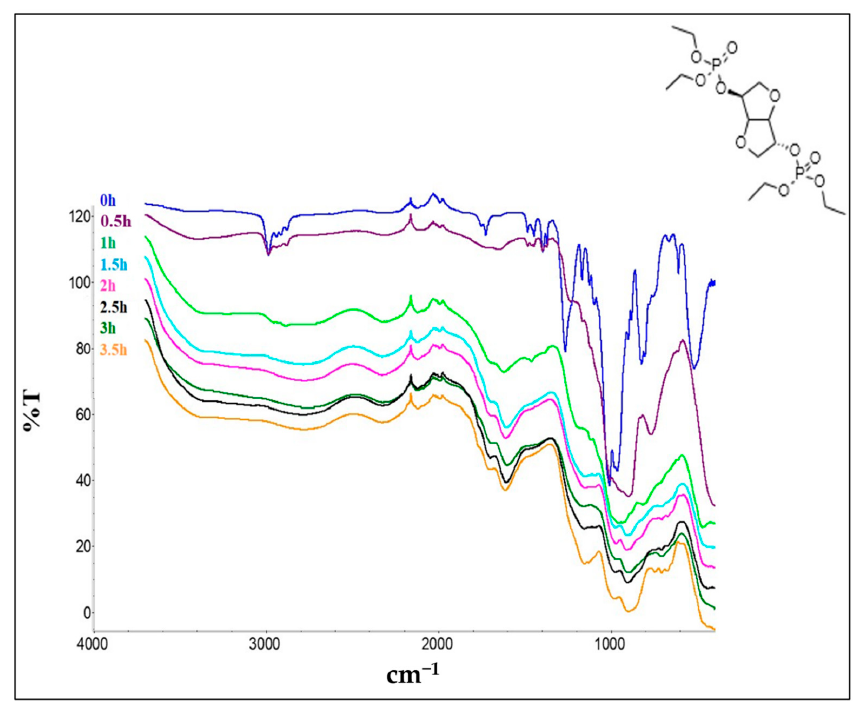
Figure 4. Degradation of Isosorbide bis -Phosphorus Esters at 200 °C. The phosphate esters (IDEA, IDPA) degrade rapidly at this temperature, the phosphinate (IDPO) much less rapidly, and the phosphonate (IDOPYL) is little changed after several hours at this temperature. The initial degradation process for these